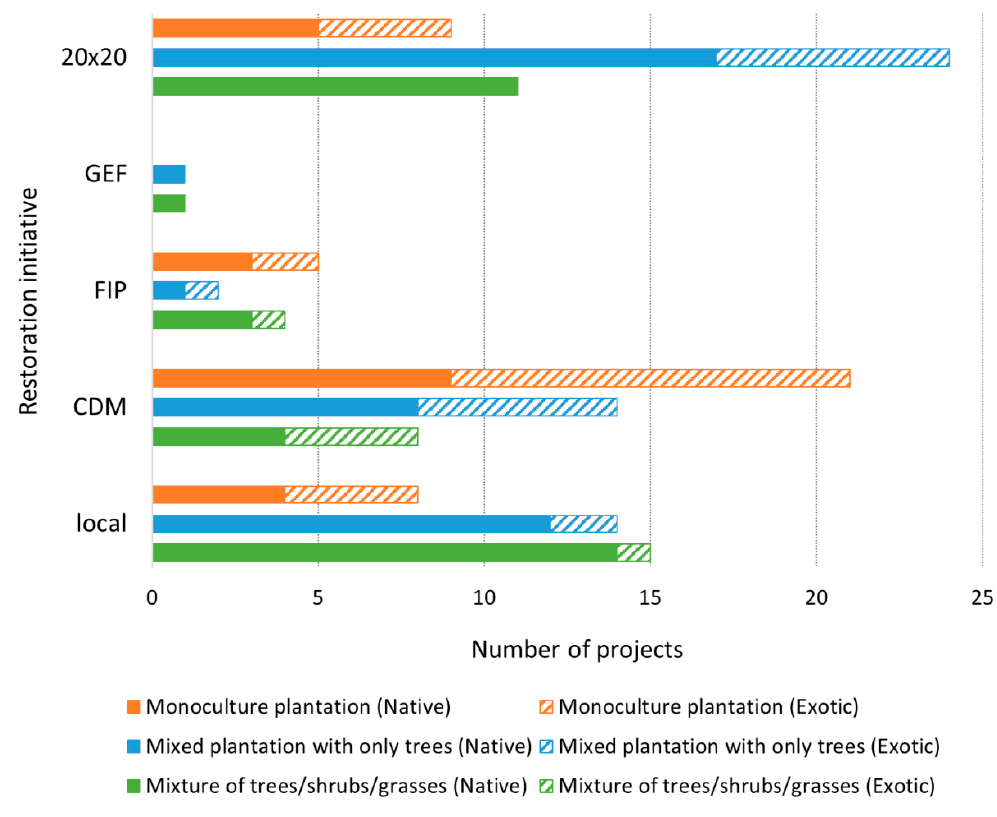
Figure 3. Number of projects that use a certain type of plantation (monoculture, mixed with only trees, mixture of trees/shrubs/grasses), with sub-division in type of species (native, exotic) used by the projects from different initiatives. Note: multiple plantations can take place within one project and one plantation can include exotic and/or native species. Therefore the total number of plantations displayed in the figure can exceed the total number of projects per initiative.